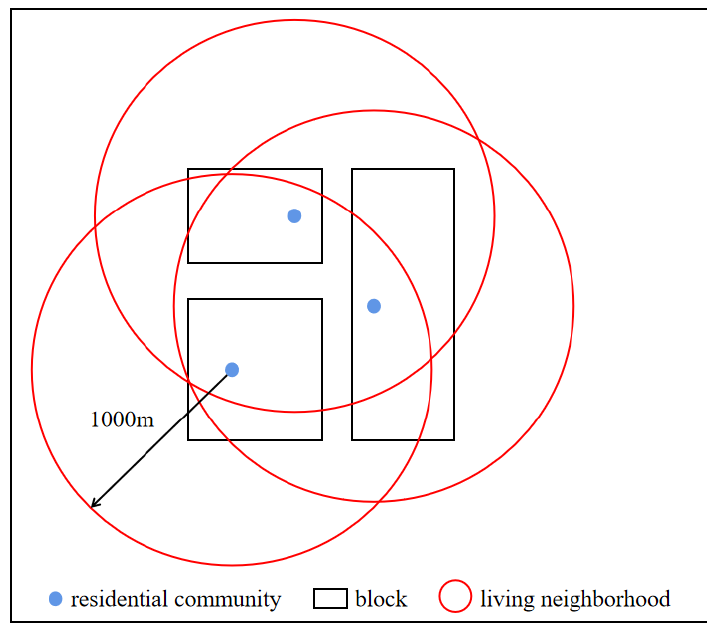
Figure 4. Residential community, block, and life circle.